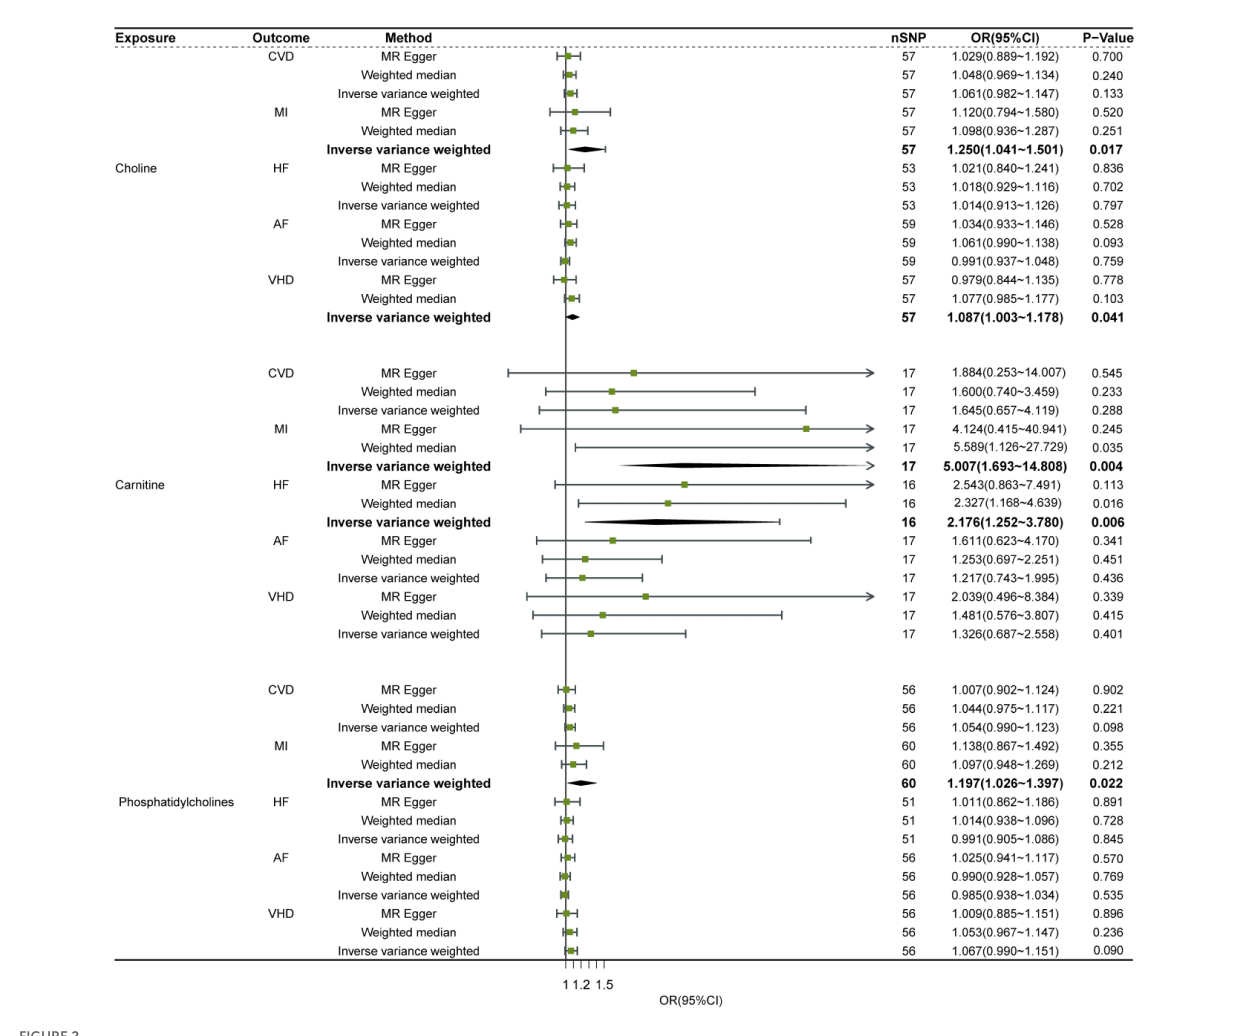
of 0.003 (0.05/15). All MR analyses were conducted using R software (version 4.1.0) with R packages including TwoSampleMR, MendelianRandomization, and